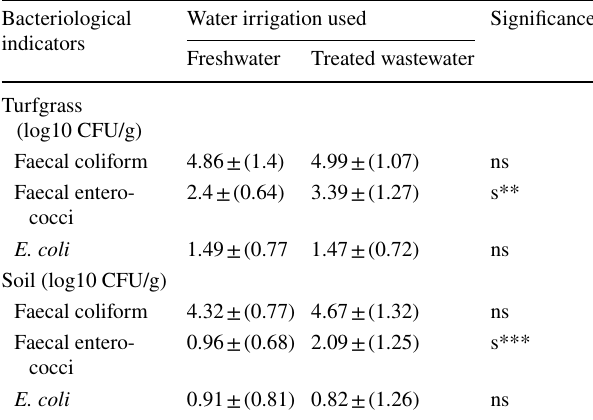
ns not significant, s significant, ** p ≤ 0.01; *** p